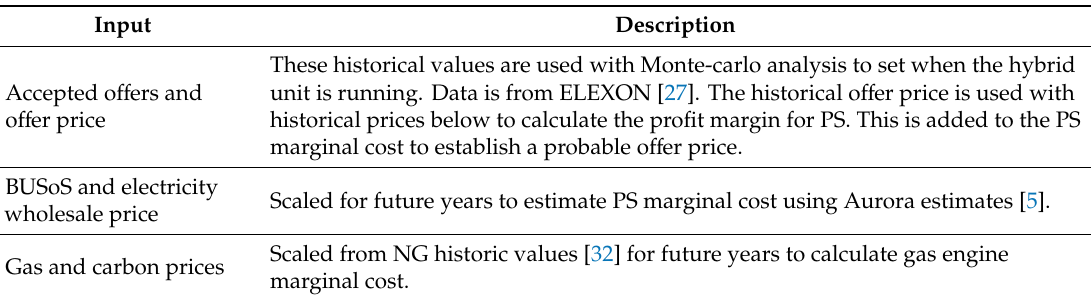
Table 7. Historical inputs to the